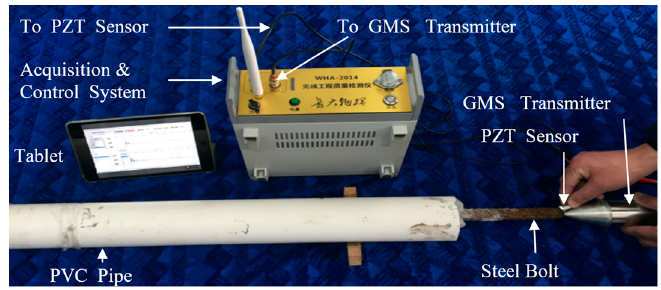
Figure 5. Instrumentation and experimental setup.